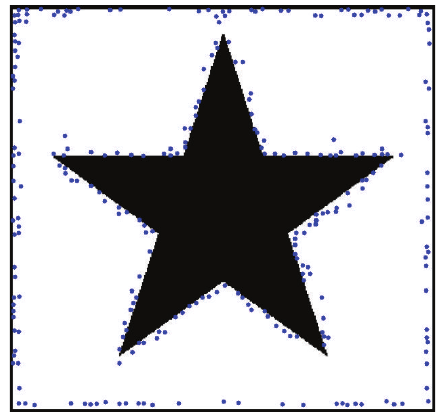
Figure 8: Final result of boundary